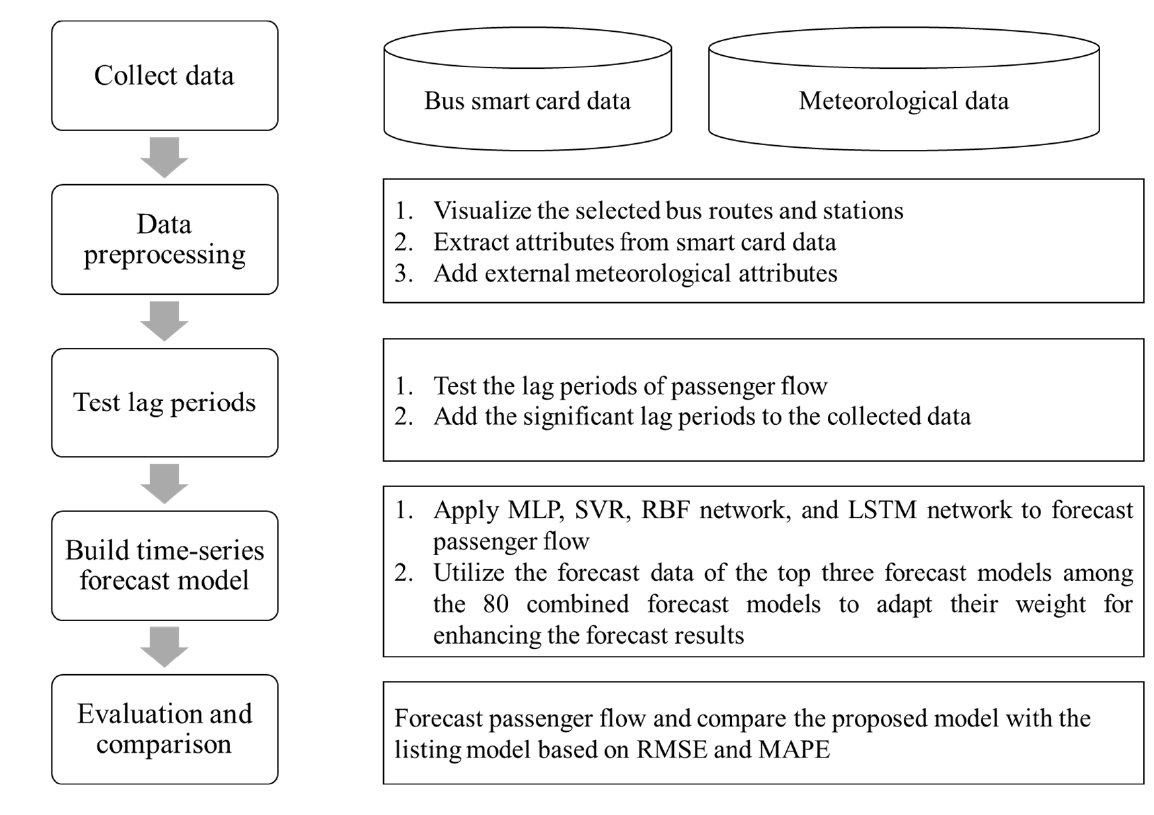
Figure 1. Proposed procedure. Table 1. Original 42 data attributes.